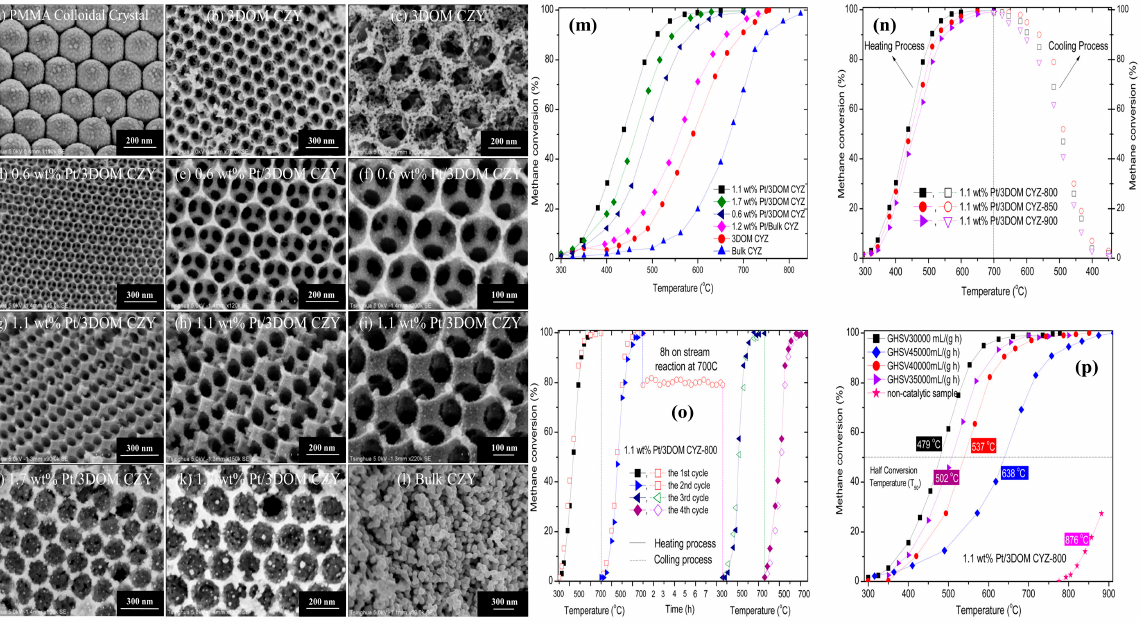
Figure 9. ( a - l ) HRSEM images of the 3DOM Ce 0.6 Zr 0.3 Y 0.1 O 2 support and x wt% Pt/3DOM Ce 0.6 Zr 0.3 Y 0.1 O 2 and Bulk Ce 0.6 Zr 0.3 Y 0.1 O 2 catalysts; ( m ) methane conversion versus temperature over